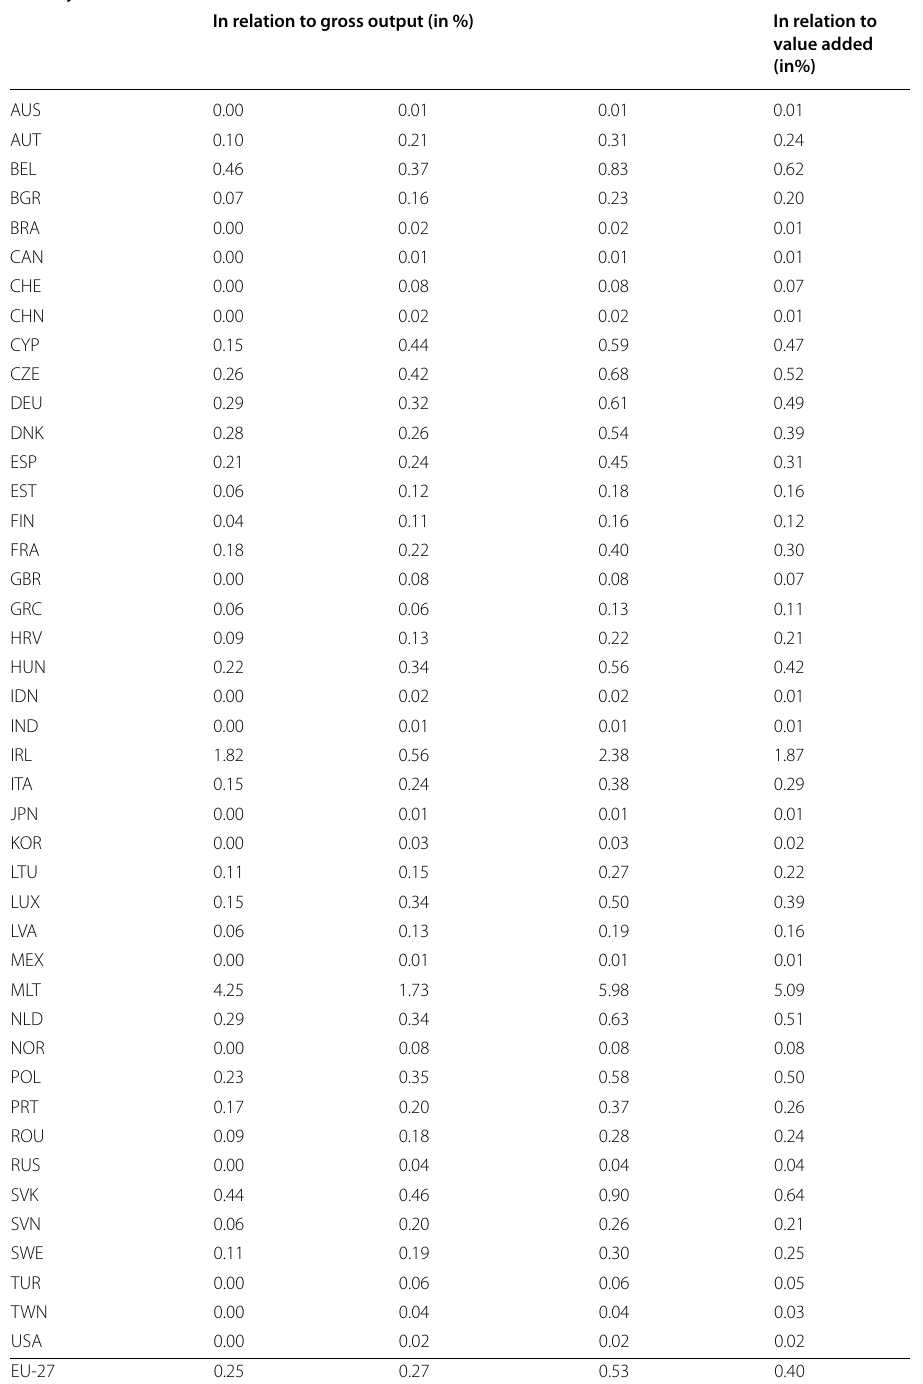
Table 2 Output effects of a decline in UK import demand for final goods from the EU (no‑deal Brexit) by